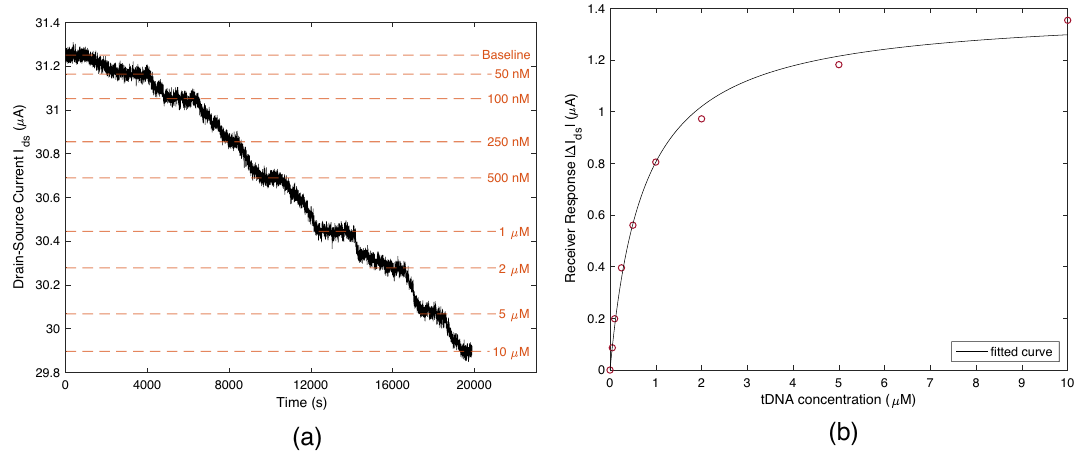
Figure 10. ( a ) Real-time sensing response of the MC receiver in terms of drain-source current I ds with varying concentration of complementary target DNAs (tDNAs). ( b ) Equilibrium sensing response fitted by the Langmuir adsorption isotherm. Resulting dissociation constant for pDNA-tDNA hybridisation is K D